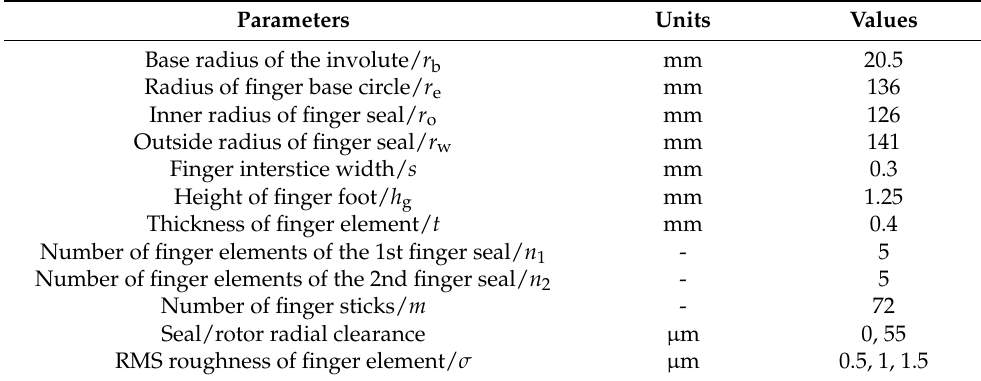
Table 1. Structural parameters of